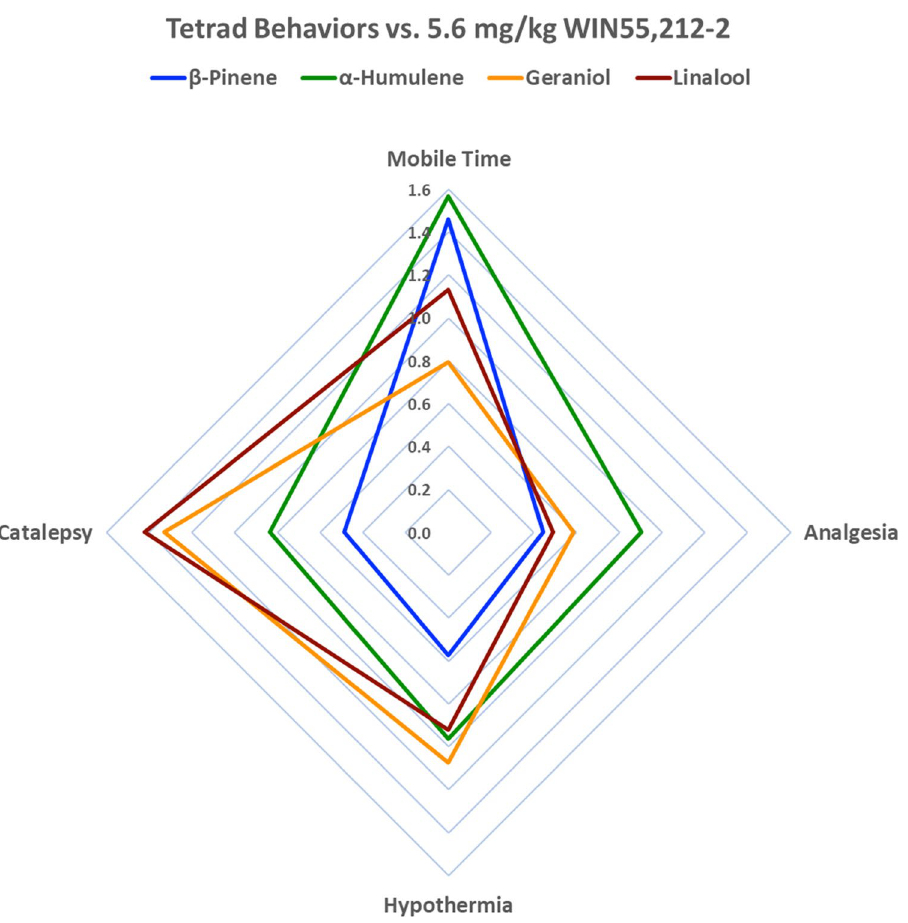
Figure 1. Terpenes Induce Cannabimimetic Tetrad Behaviors in Mice. Behavioral analysis data from Figs. S1- S3 represented in a radar chart format. The percent change from baseline for each terpene in each behavior was determined; the peak effect for tail flick was selected (Fig. S1) while the other behaviors only had a single time point. This percent change was then normalized to the % change of 5.6 mg/kg WIN55,212-2 (1.0 on the chart above). The chart demonstrates that while all terpenes induce all 4 tetrad behaviors, they do so with varying efficacy; they also vary whether the effect is stronger or weaker than the positive control